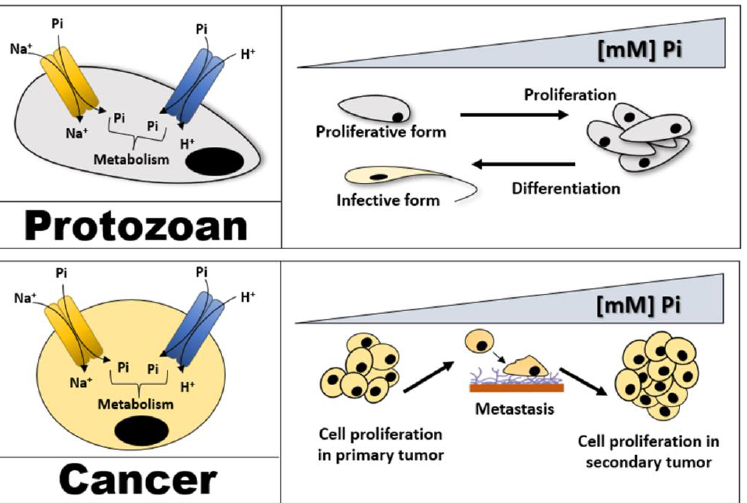
Figure 1. The Pi transporter is related to the proliferation of cell types ranging from protozoa to cancer cells. Na + -dependent Pi transport and H + -dependent Pi transport are essential for intracellular Pi acquisition and possibly provide Pi for the metabolism of these cells. In protozoa, higher extracellular Pi concentrations promote proliferation, whereas lower concentrations induce differentiation into the infective (nonproliferative) form. In cancer cells, high extracellular Pi levels are implicated in numerous stages of tumour processes, including proliferation and metastasis. Pi uptake through the plasma membrane is the starting point for this anion, and it is